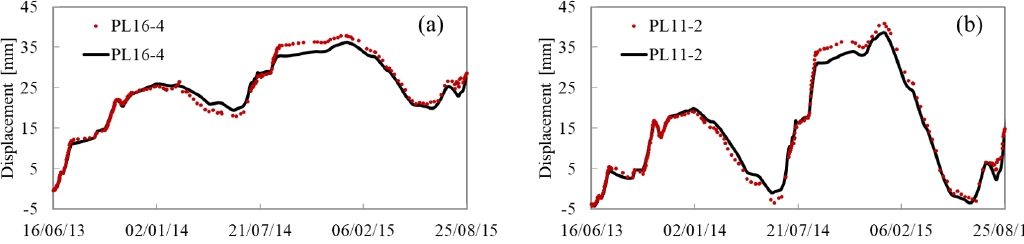
Figure A3. The fitting and forecast results of Class 4: ( a ) IP 11-5; ( b ) IP 9-4; ( c ) PL 9-3; ( d ) PL 11-1.